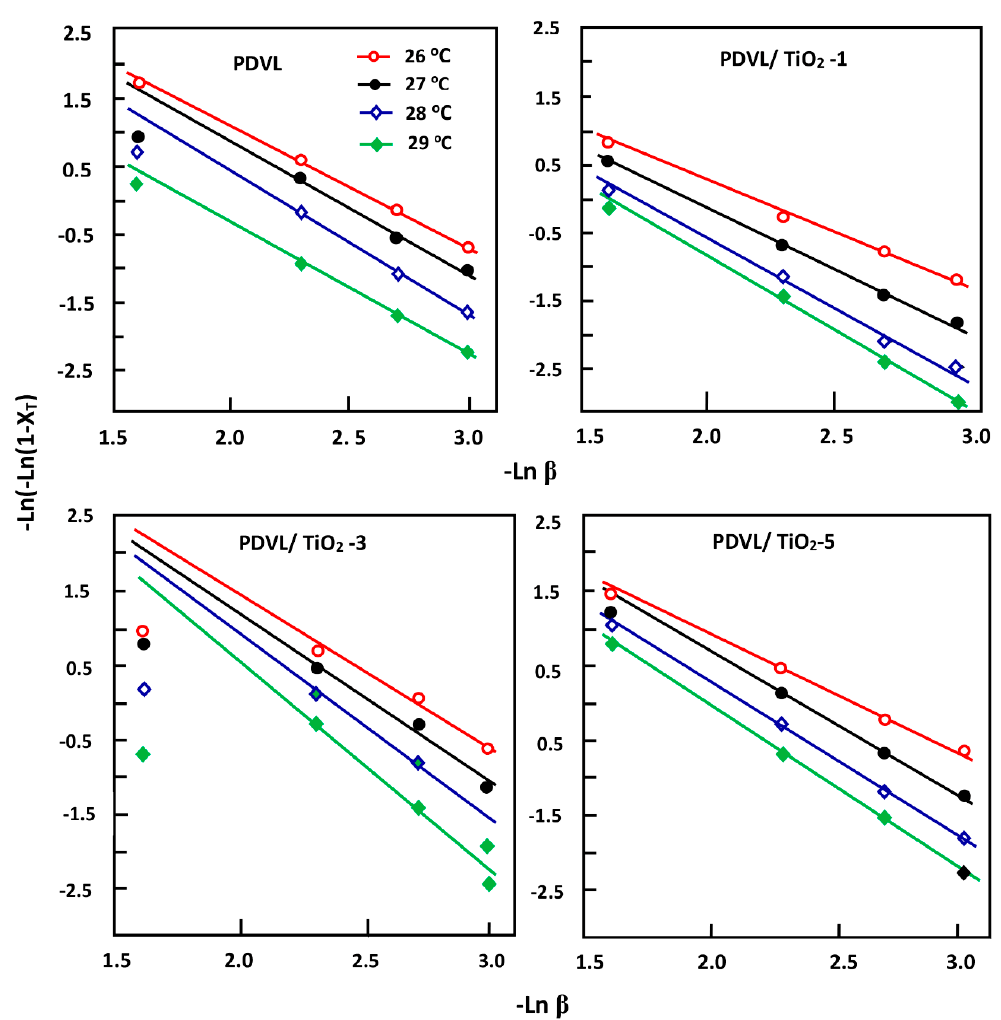
Figure 9. Ozawa plots indicating the variation of ln[ln(1 − X T )] vs. ln β for pure PDVL and PDVL/TiO 2 systems containing 1, 3, and 5 wt % of TiO 2 loading.